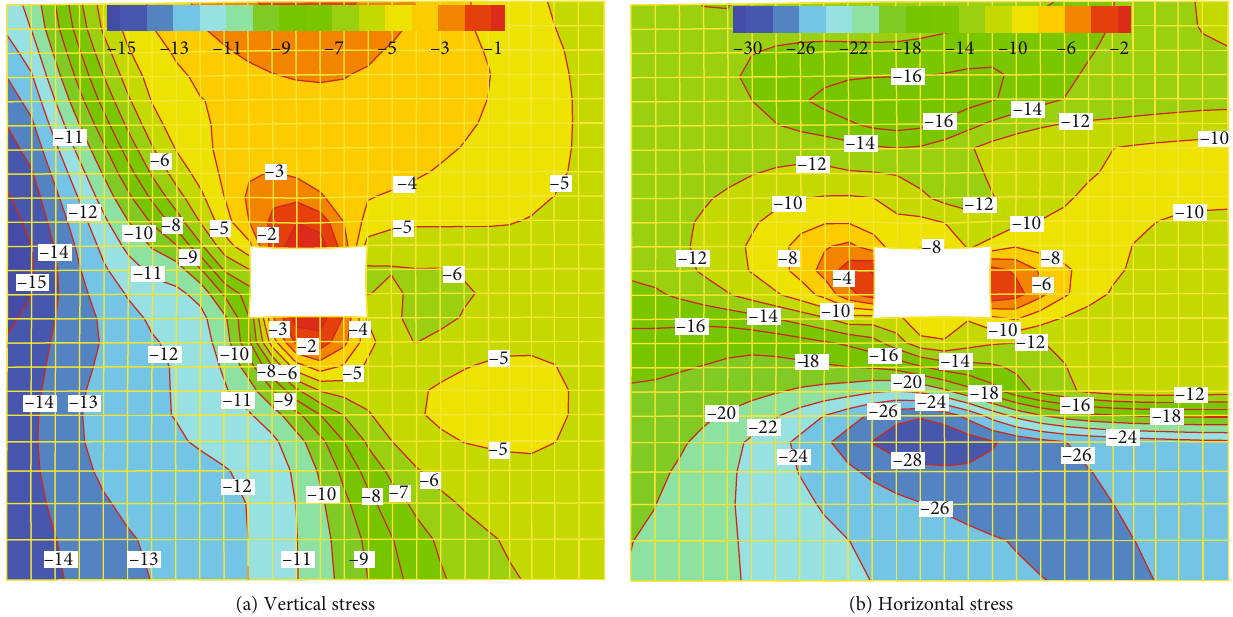
Figure 19: Distribution law of stress fi eld in surrounding rock of roadway after mining.